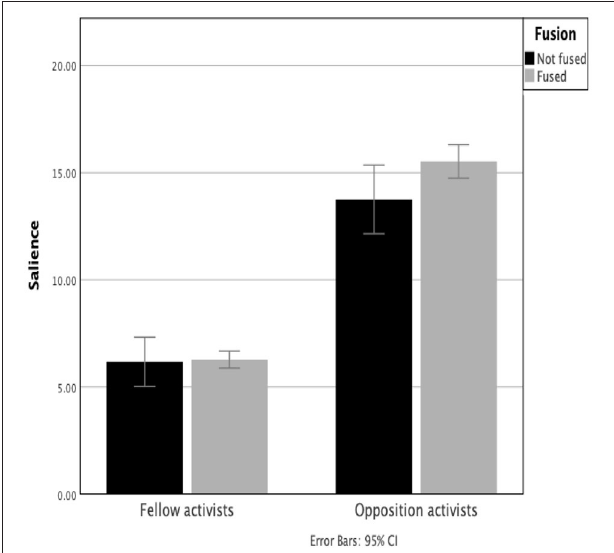
FIGURE 7 | Salience of fellow and opposition activists by fusion